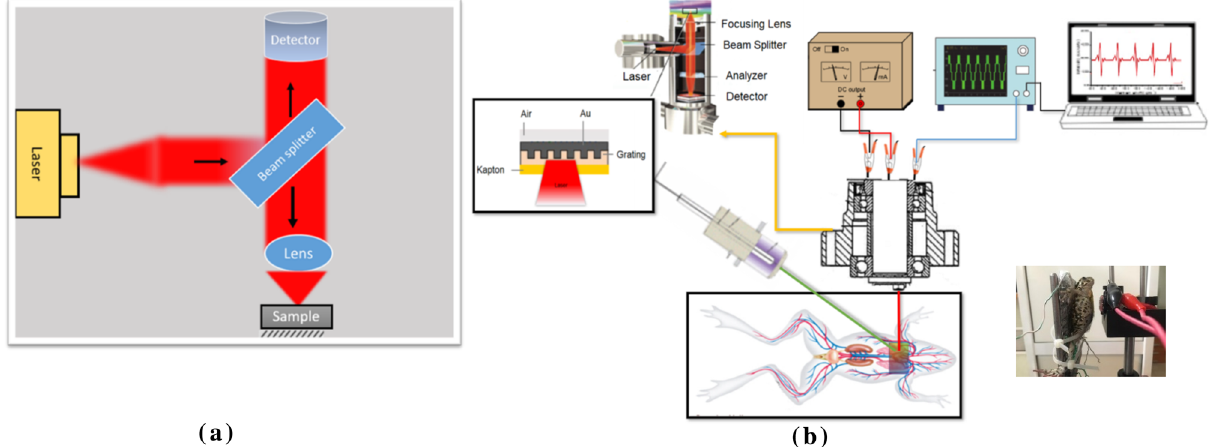
Figure 1. ( a ) optical setup of microchip and ( b ) main experimental setup which use for signal recording with and without green laser pumping and in the inset: real pic of experimental setup with